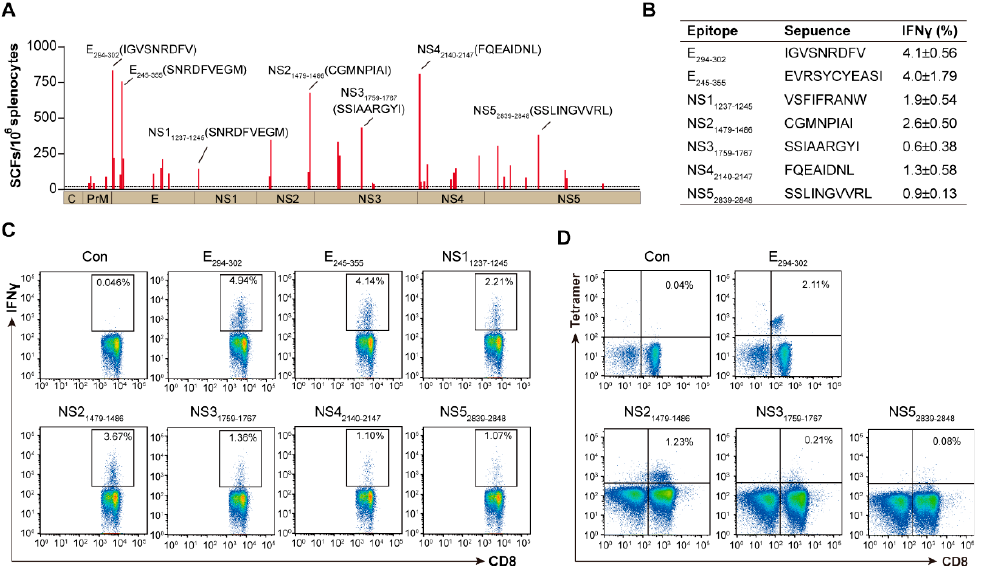
Figure 5. Identification of ZIKV epitopes recognized by CD8+ T cells in H-2 b mice. Wild-type C57BL/6 (H-2 b ) mice were infected with 10 4 FFU of ZIKV, splenocytes were harvested at 14 d.p.i. and stimulated with epitopes (H-2 b : Kb and Db) predicted from above-positive peptides. ( A ) Thirty-nine epitopes were identified by IFN- γ -ELISPOT assays. ( B , C ) The seven strongest positive epitopes from each protein are marked in the table ( B ). The percentages of IFN- γ produced in CD8+ T cells by stimulation with seven epitopes are represented, Con means without epitope stimulation ( C ).